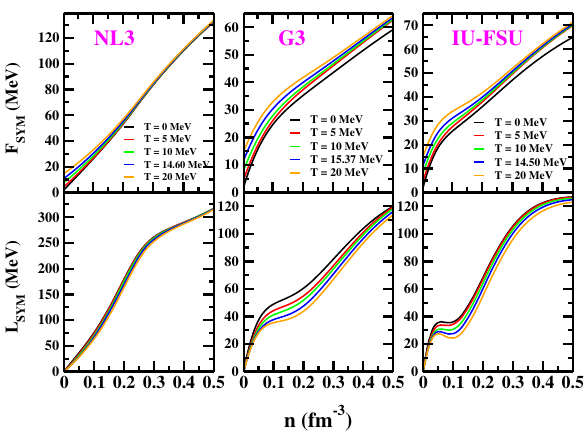
Fig. 5 Variation of symmetry energy and slope parameter at saturation density ( F sym , 0 and L sym , 0 ) with temperature for SNM ( t = 0)